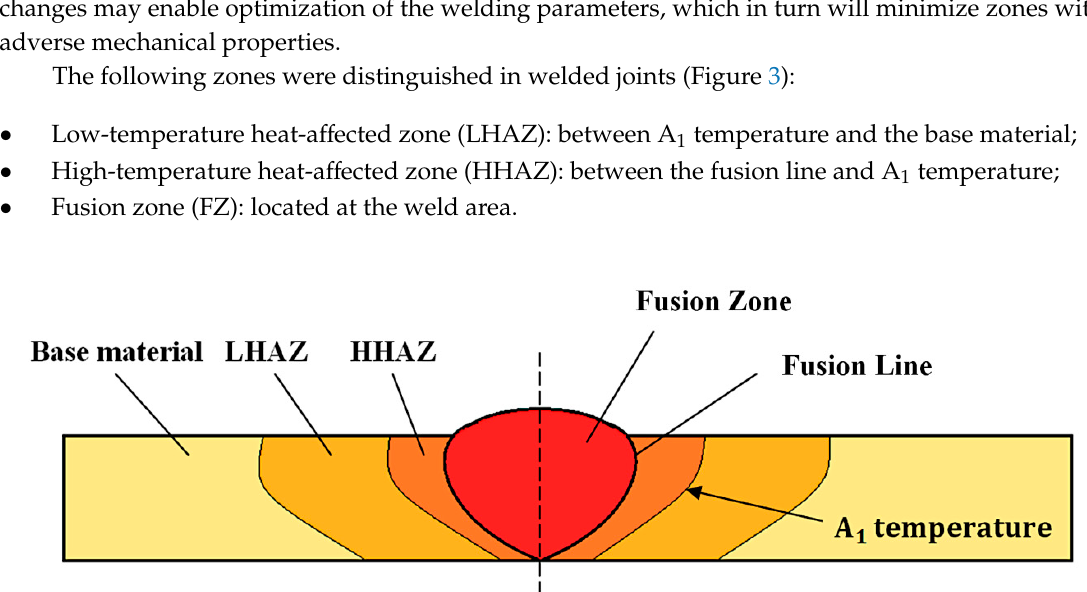
Figure 3. Scheme of welded joint.